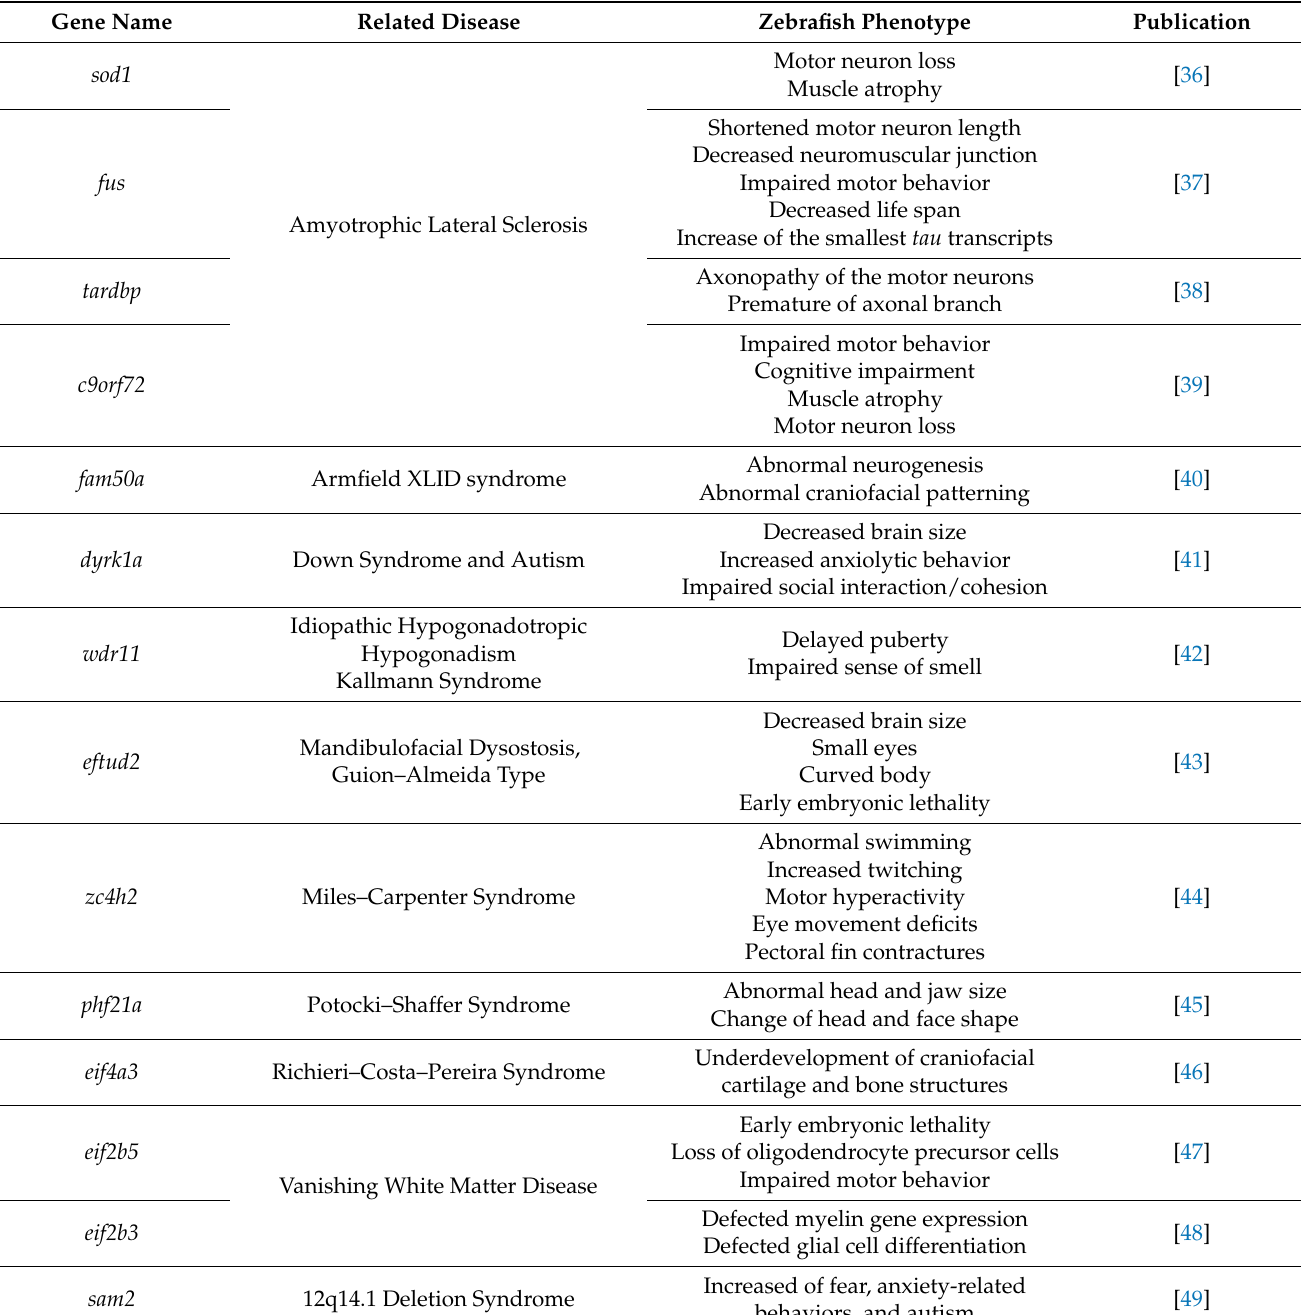
Table 2. Zebrafish modeling for rare neurological